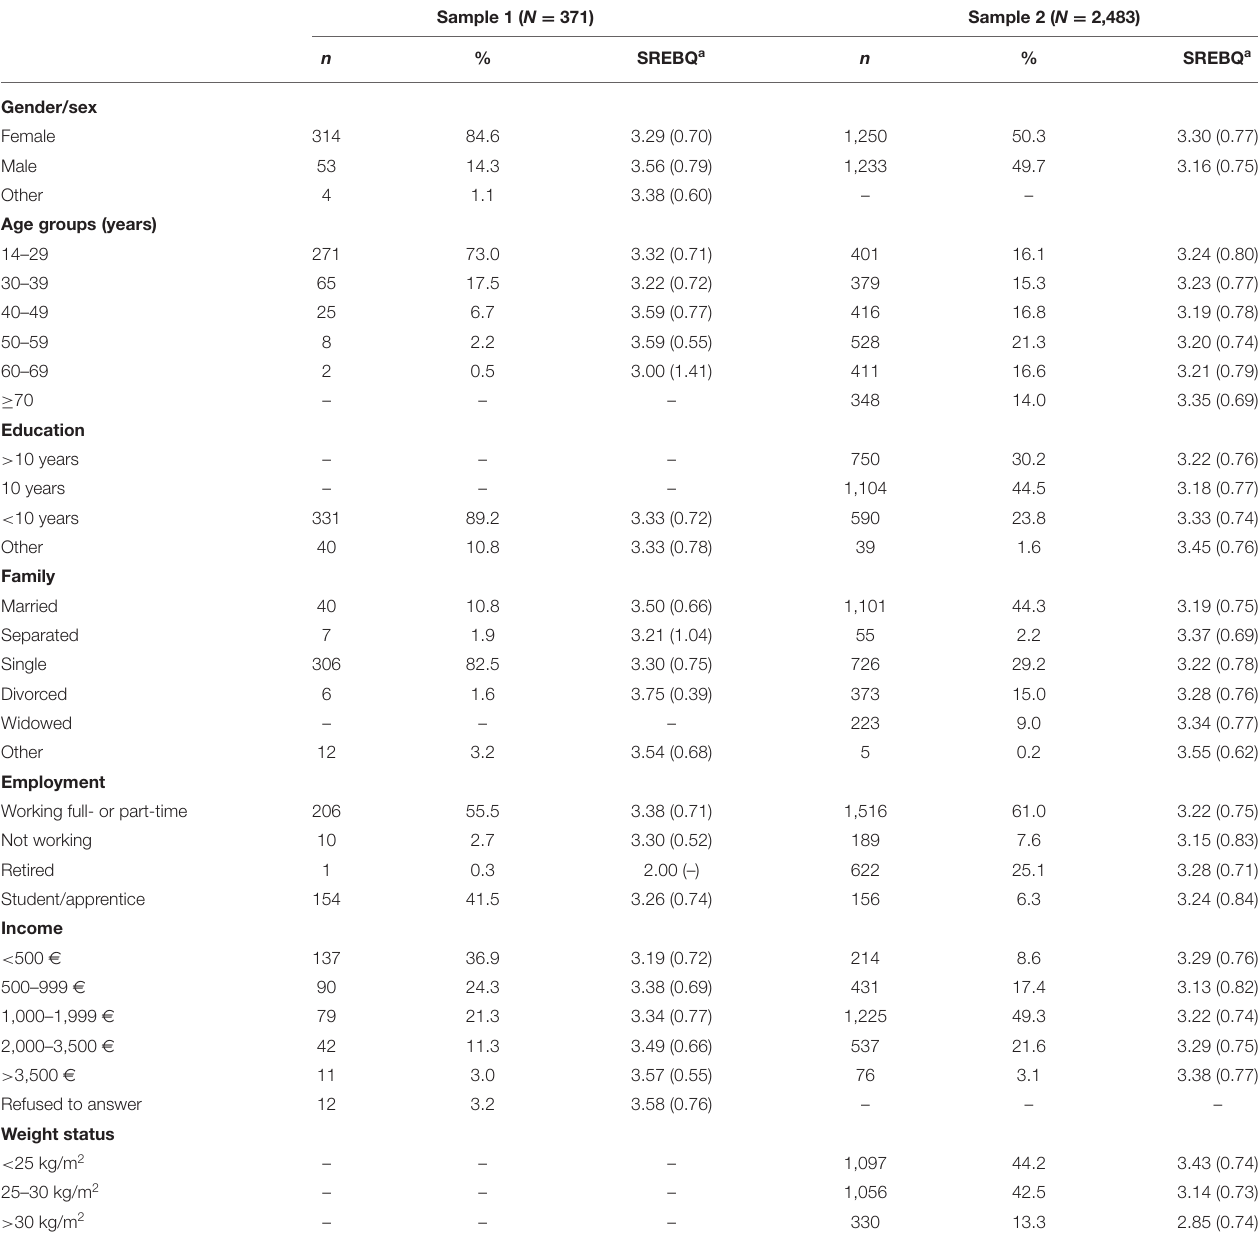
TABLE 1 | Sociodemographic characteristics of both